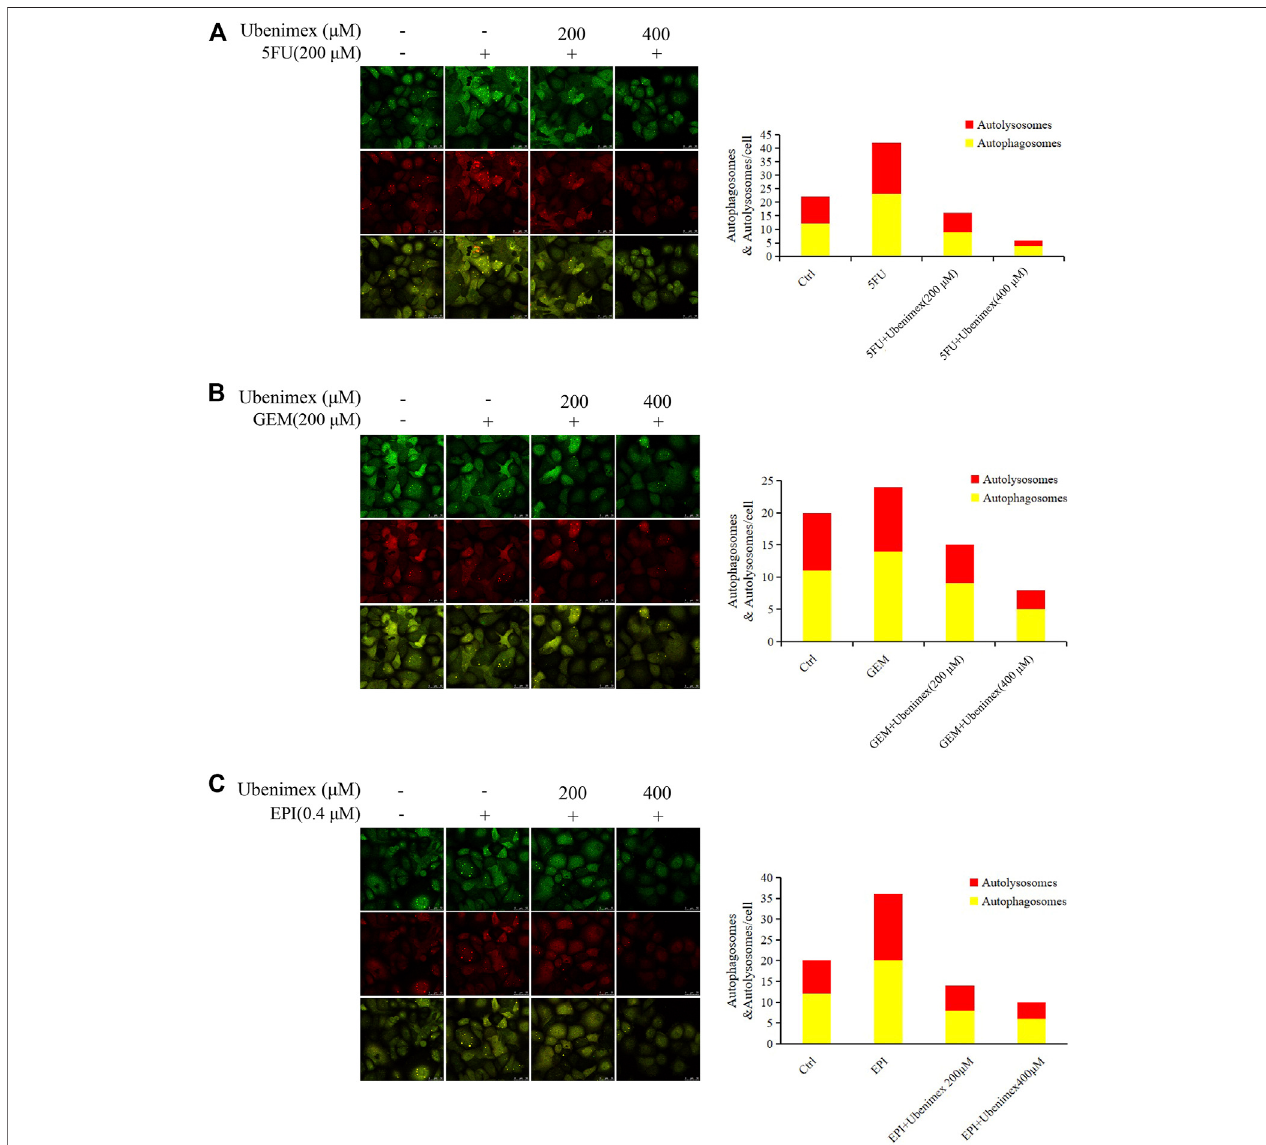
FIGURE 5 | ROS upregulates CD13 expression and induces cell autophagy. (A – C) PLC/PRF/5 cells transfected with StubRFP-sensGFP-LC3B lentivirus and treated with 5FU, GEM or EPI alone or in combination with ubenimex. Quanti fi cation of autophagosome and autolysosome formation (puncta staining sites) per cell. * p ≤ 0.05, ** p ≤